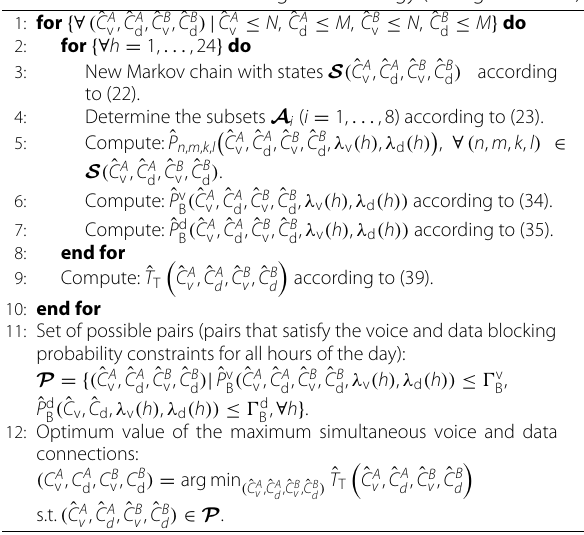
Table 7 Network dimensioning methodology (configuration